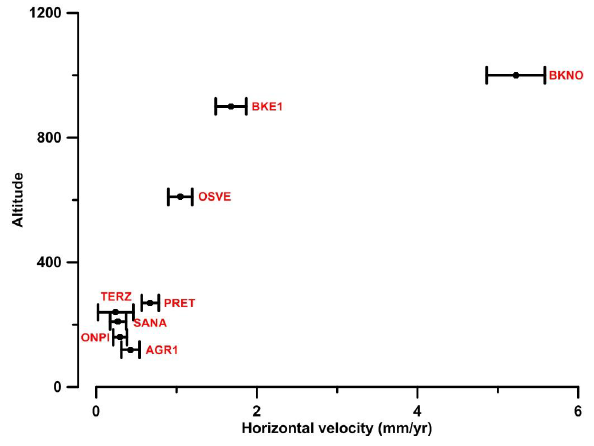
Figure 6. Altitude of GPS stations versus horizontal velocity.